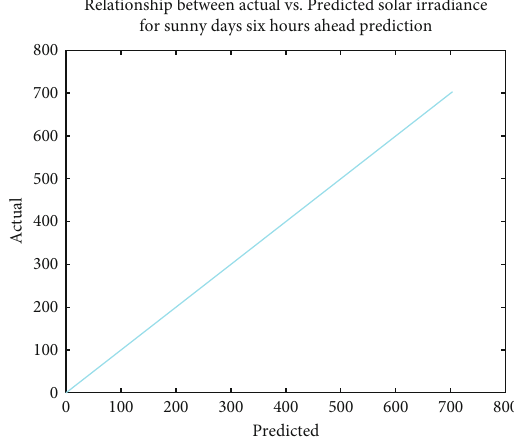
Figure 18: Relationship between actual vs. predicted solar irradiance for sunny day fi ve-hour-ahead prediction.